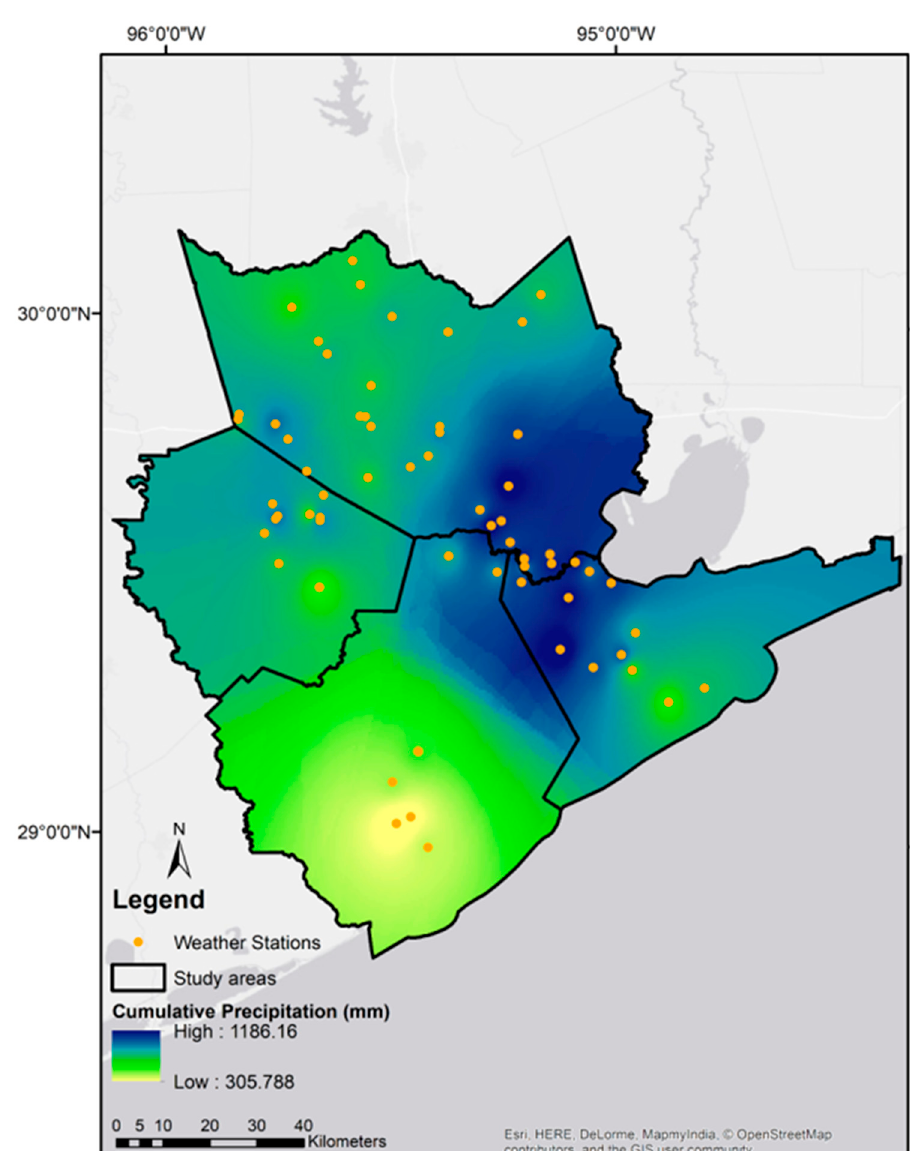
Figure A1. Cumulative rainfall pattern map during hurricane Harvey, 2017